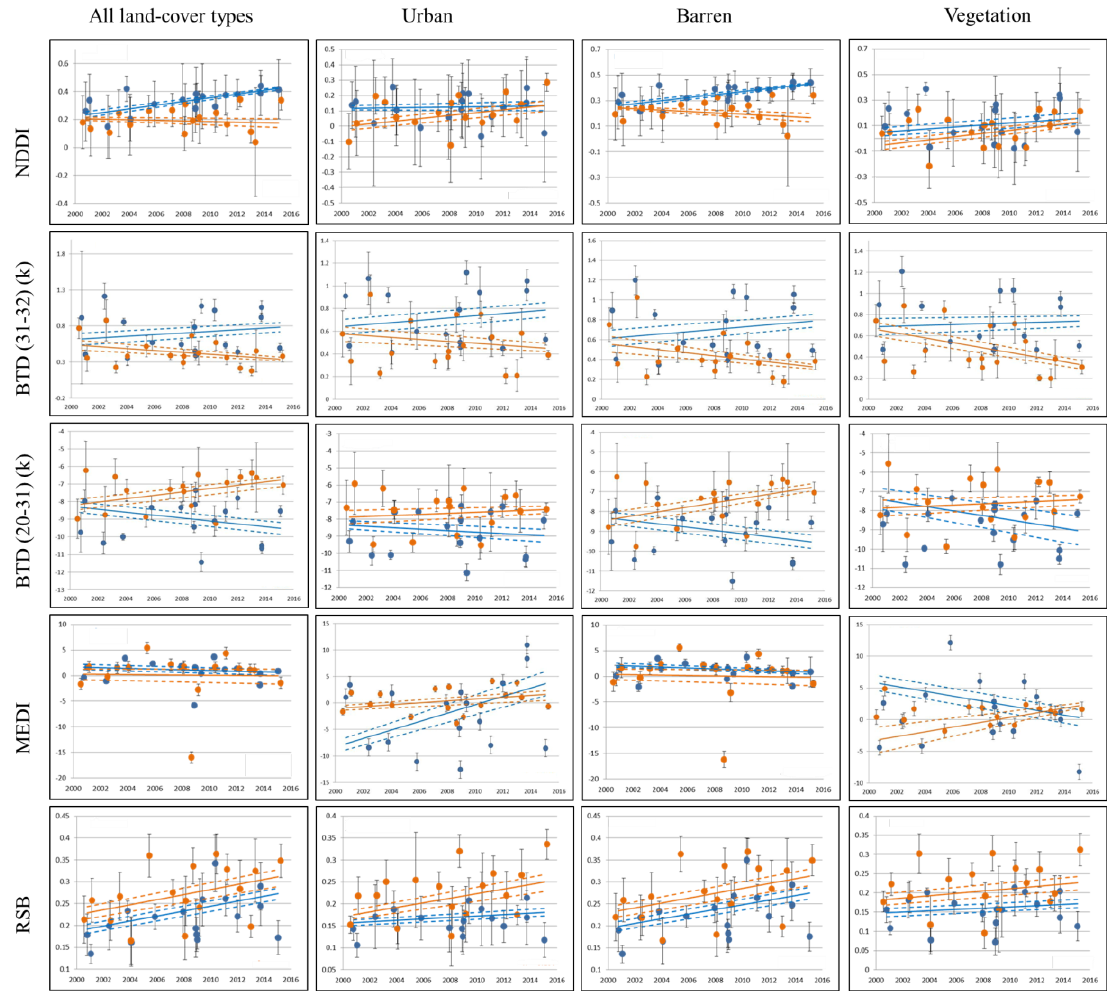
Figure 5. Dust indices generalized for all land-cover types and land cover-specific analysis (urban, barren and vegetation). The scatter plots showing for all indices the temporal trends fitted through the mean index value per event as a result of a linear regression, with associated model error bounds (at 95% confidence interval) considering all pixels. The error bars represent the standard deviation for each individual observation. The orange dot represents the dust data and the blue non-dust. The units for all indices are dimensionless, except for BTD where this is in Kelvin.